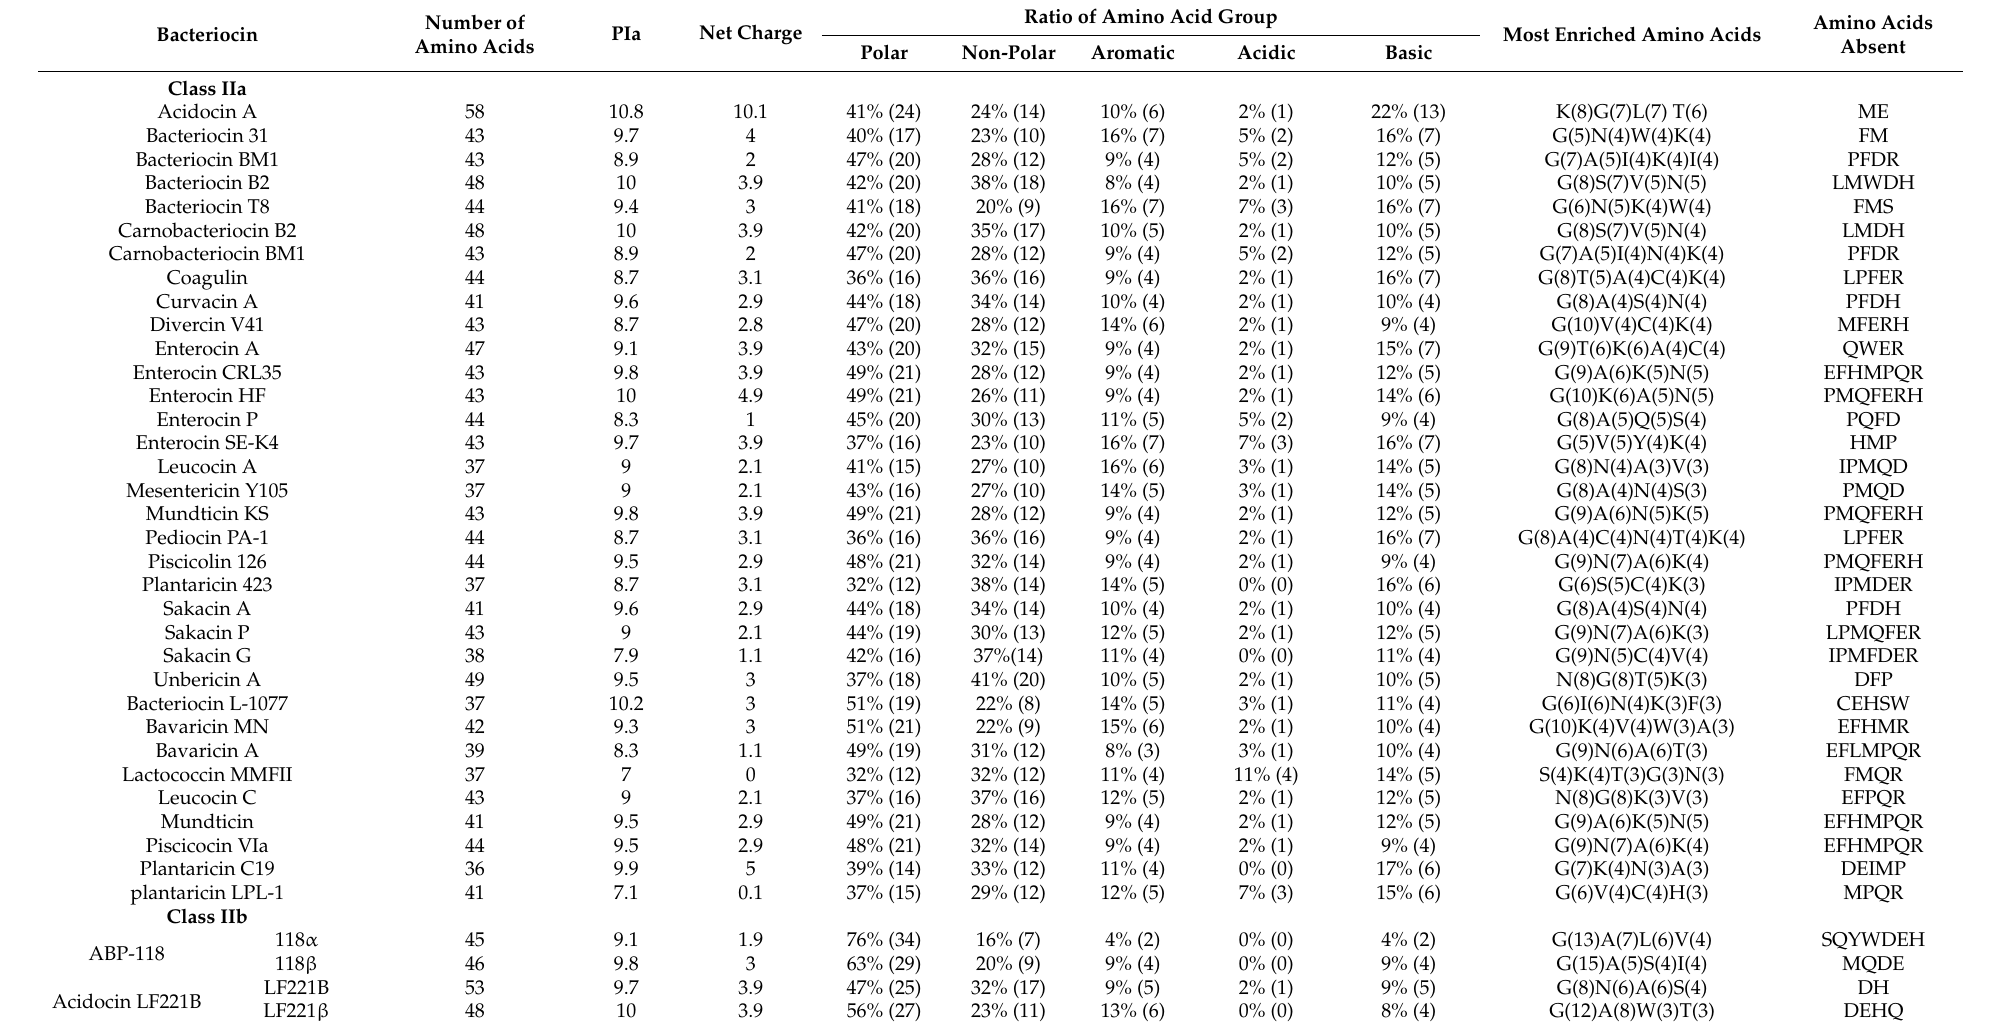
Table 2. Characteristics of the amino acid sequence of class II bacteriocins of